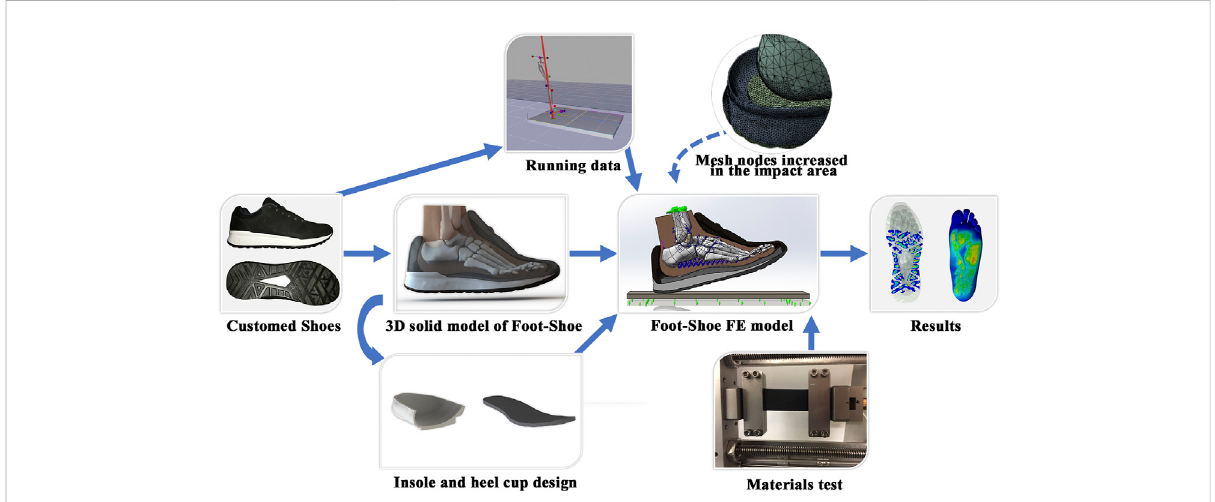
FIGURE 1 Overview of the foot – shoe FE model. The 3D solid model of foot – shoe is based on custom shoes. Different insole and heel-cups were designed in SOLIDWORKS, and various midsole and insole materials were tested. Kinematic and kinetic running data were collected and input as boundary conditions, and mesh nodes in the impact area were increased to obtain smooth prediction